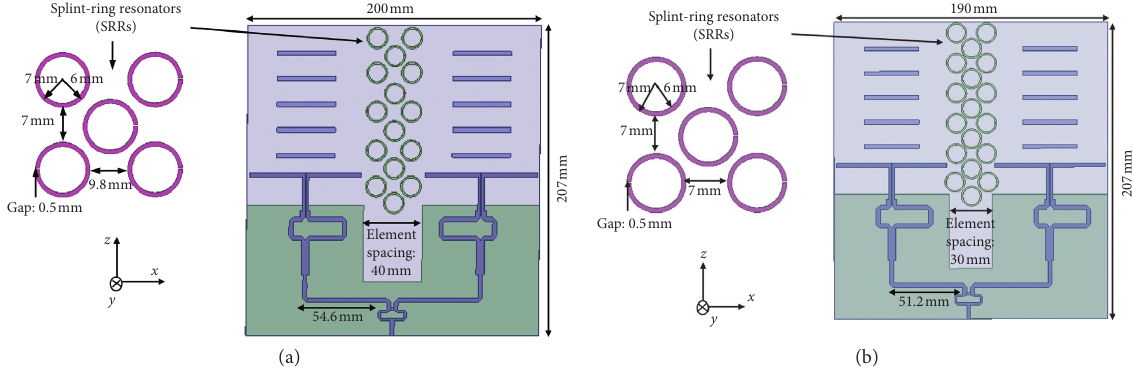
Figure 9: Quasi-Yagi antenna array with SRRs. (a) Inverse balun. (b) Directional balun.